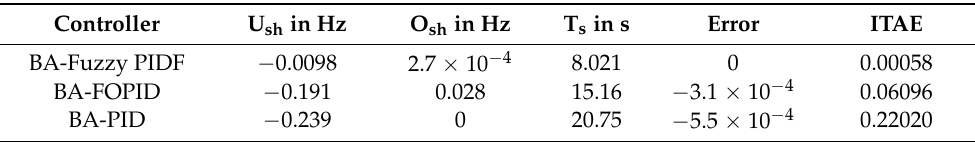
Figure 16. Comparison of three controllers tuned by BA based on ITAE for LFC of the GB system in scenario 2 with 0.053 pu load disturbance. Table 18. Frequency response performances with BA-tuned controllers designed via minimizing ITAE in scenario 2 with 0.053 pu load